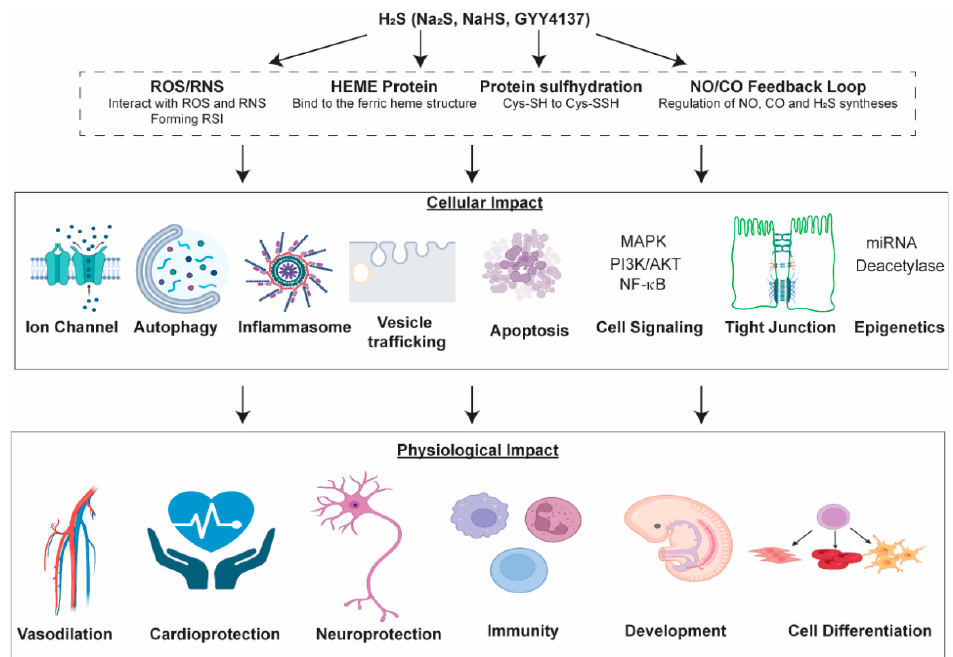
Figure 6. Illustration of the direct targets of H 2 S and the downstream cellular/physiological impacts.